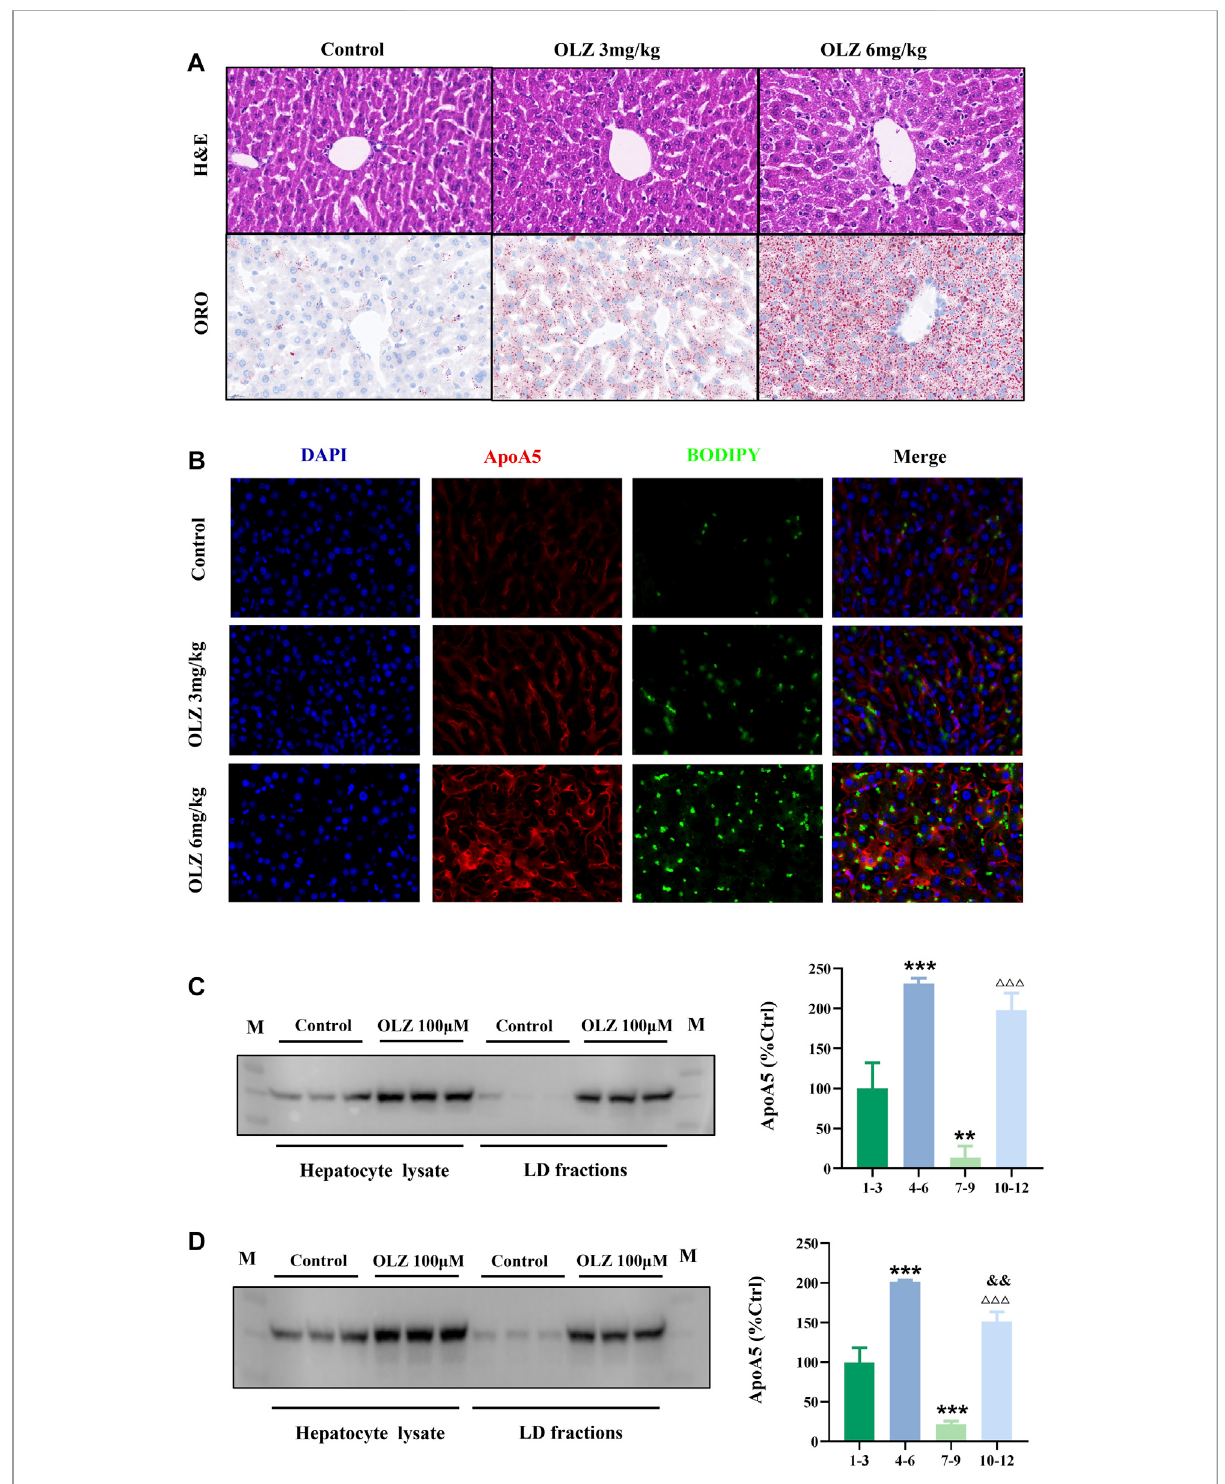
FIGURE 4 Effectsofolanzapine-inducedtriglycerideaccumulationintheliverandonapoA5subcellularlocalizationalternation. (A) H&EandOROstaining and (B) double immuno fl uorescence of mouse liver sections. The liver sections were fi xed, permeabilized, and incubated with a mouse monoclonal anti-apoA5 antibody,followedbyincubationwith Alexa647-conjugated anti-mouseIgG(red).The nuclei ofthecorresponding cellswerevisualized using 4 ′ ,6-diamidino-2-phenylindole (DAPI) staining (blue). Lipid droplets were stained with BODIPY 493/503 (green). HepG2 cells (C) and primary mouse hepatocytes (D) were homogenized and subjected to sucrose gradient centrifugation (Klaunig et al., 1981a). Western blotting